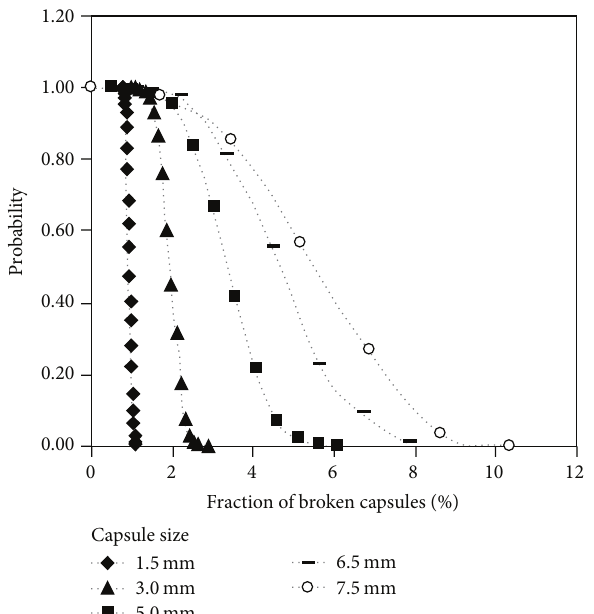
Figure 8: Amount of water released from broken capsule with different size (the degree of confidence is